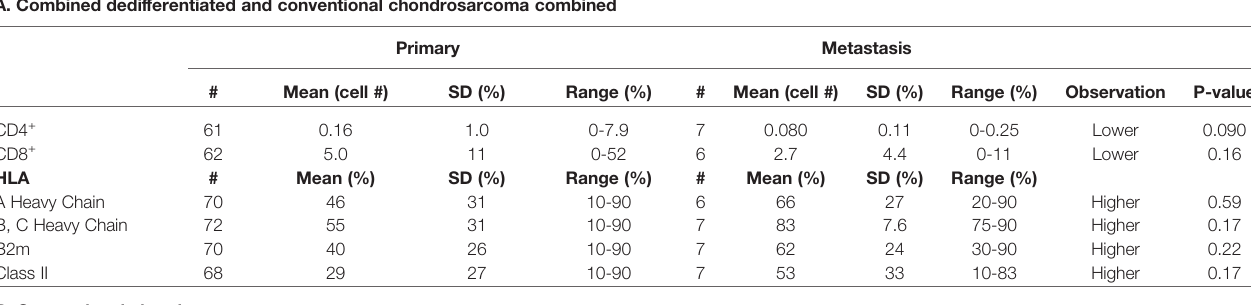
TABLE 4 | TIL, HLA Class I subunit and HLA Class II antigen expression in metastasis and in primary tumors. A. Combined dedifferentiated and conventional chondrosarcoma